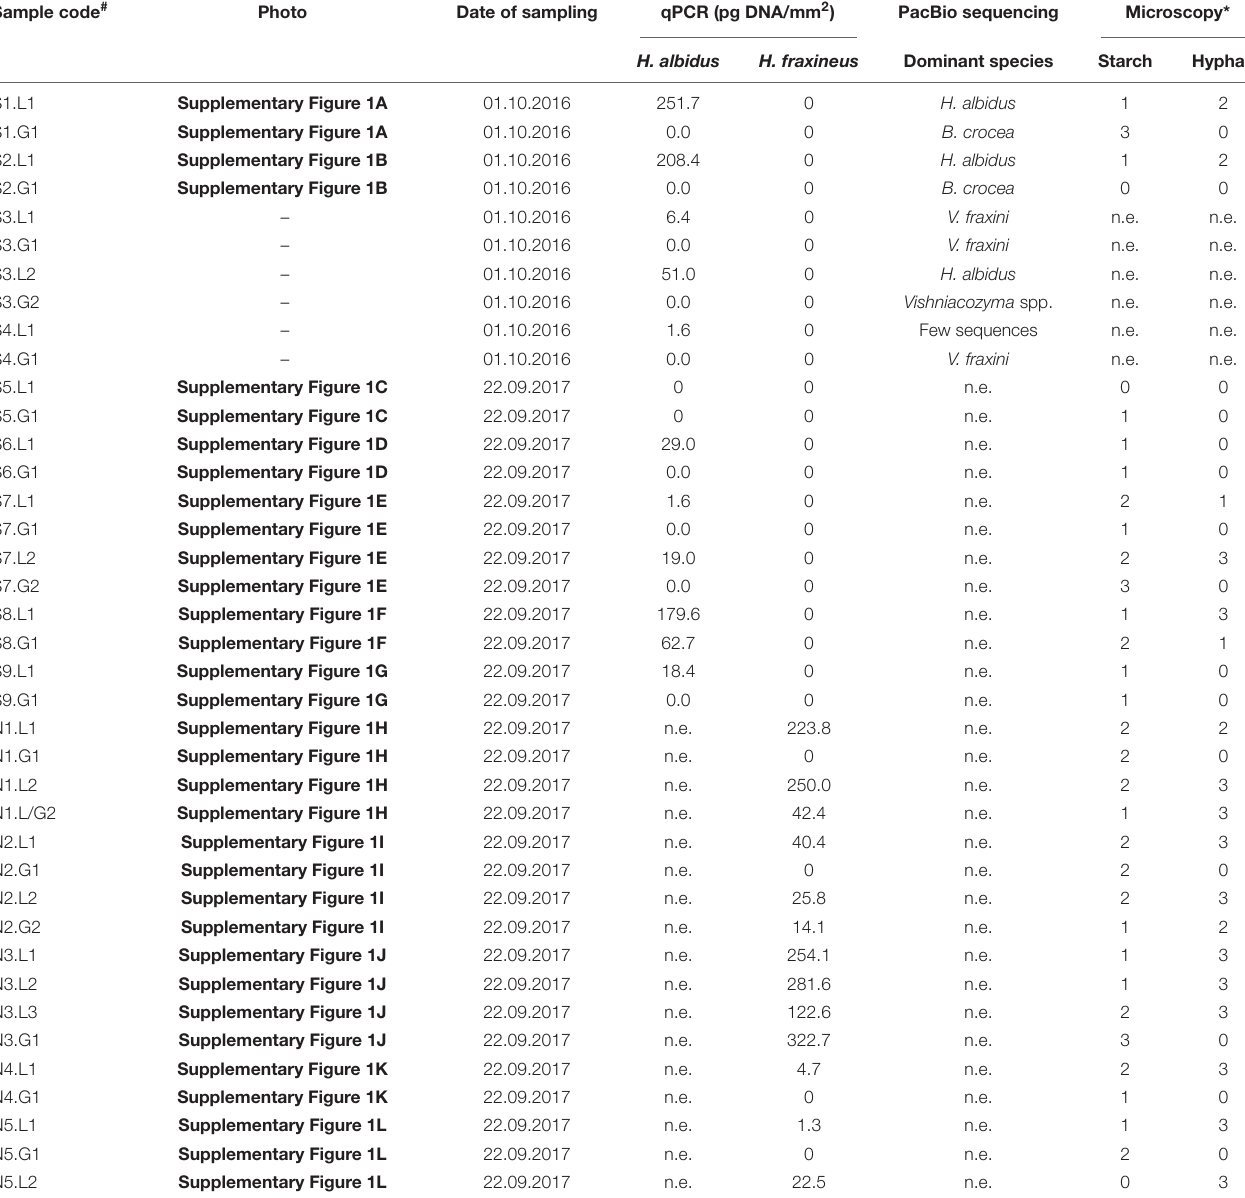
TABLE 1 | Summary of data from qPCR and microscopy analyses of necrotic and green vein tissues of leaflets collected from the Stjørdal and Norderås sites (n.e., not examined). Sample code